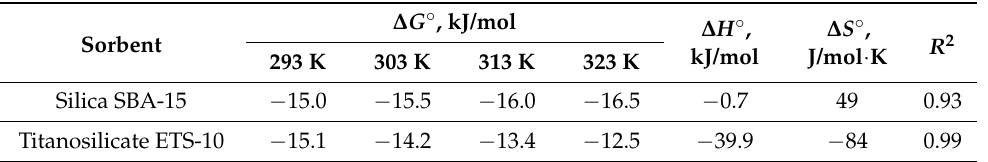
Table 4. Thermodynamic parameters of Ce(III) on studied sorbents.